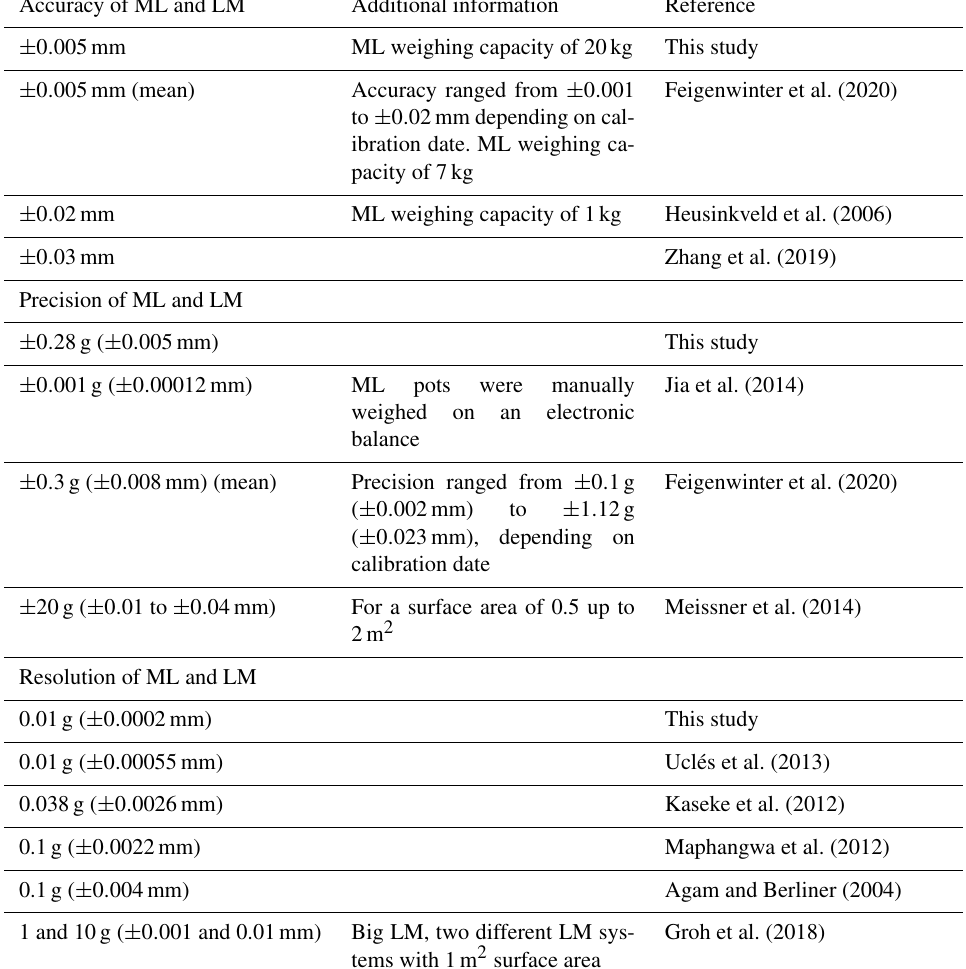
Table 3. Comparison of accuracies, precisions, and resolutions of micro-lysimeters (MLs) and lysimeters (LMs) for NRW